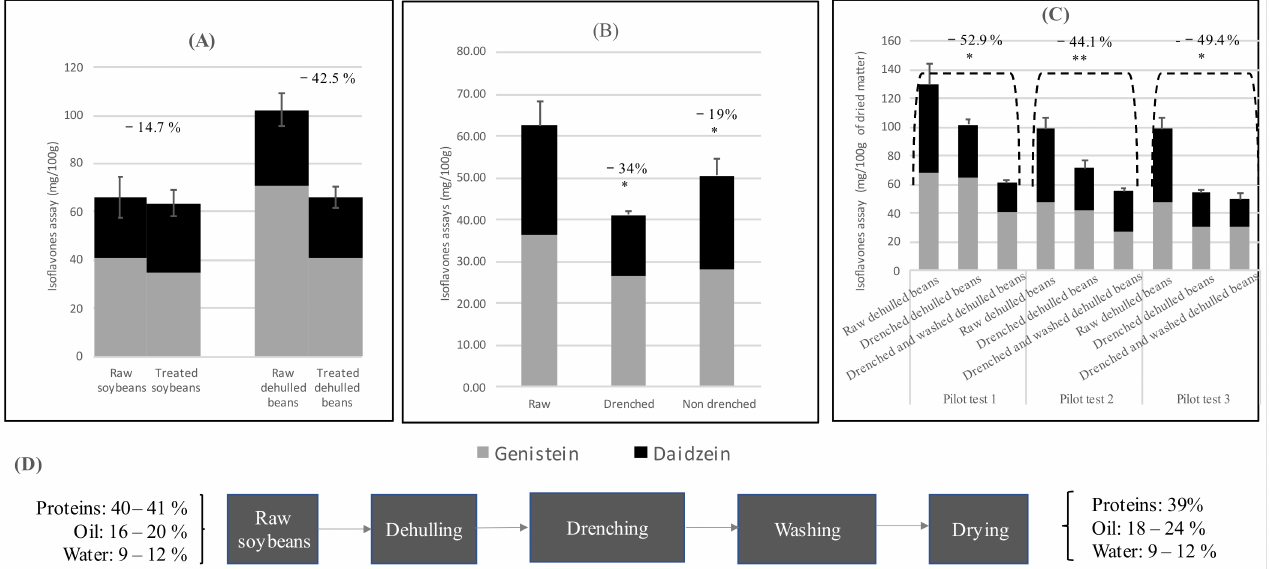
Figure 1. Results of isoflavone removal at laboratory and pilot scales. ( A ) Laboratory-scale average isoflavone removal from raw and dehulled soybeans. ( B ) Pilot-scale mean isoflavone removal from dehulled beans, with and without drenching before washing. ( C ) Pilot-scale mean isoflavone removal after application of the improved process on three pilot trials. Percentages correspond to the isoflavone reductions. Error bars are SEM. Significant differences for a risk α of 5% (*) and 1% (**) are also indicated. ( D ) Full improved pilot process overview with input and output matter